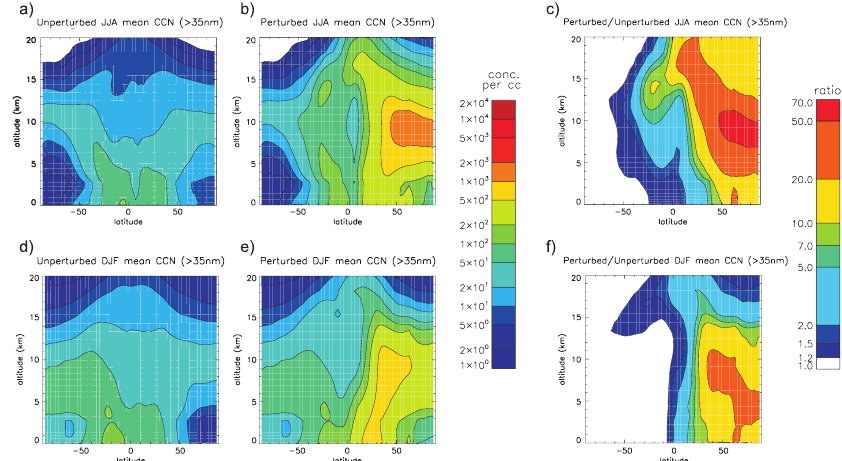
Fig. 11. Simulated zonal 3-month mean CCN concentrations (radius > 35nm, supersaturation=0.22%) per cubic centimeter (per cc) for L-s: (a) unperturbed run, (b) perturbed run, (c) ratio of perturbed to unperturbed; and for L-w: (d) unperturbed run, (e) perturbed run, (f) ratio of perturbed to unperturbed. JJA=June-July-August;